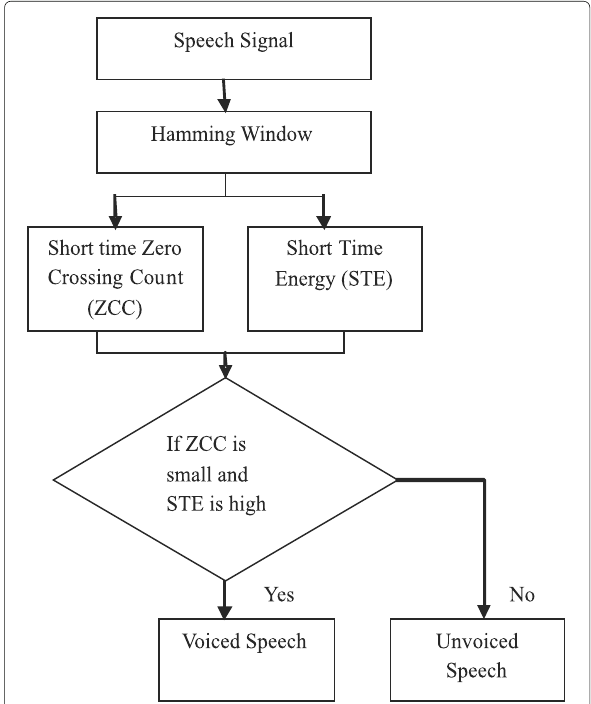
Fig. 2 Voiced and unvoiced